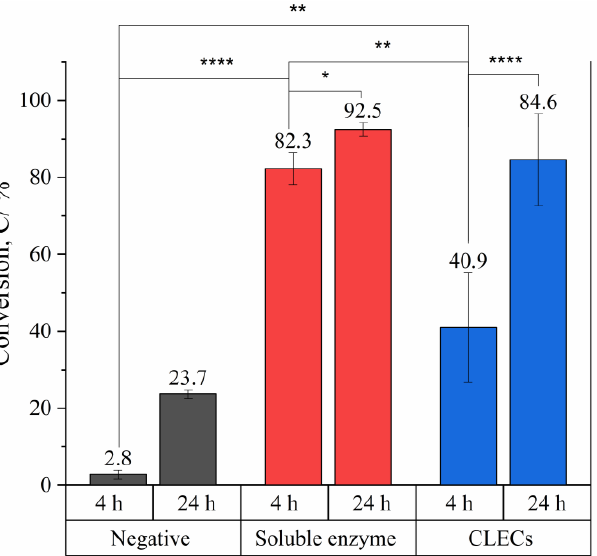
Figure 14. Epoxide ring opening of cyclohexene oxide with azide as a nucleophile after 4 and 24 h. A two-tailed t-test for two random samples was performed with a significance level of p = 0.05. Levels were determined as follows: <0.05 = *, <0.005 = **, <0.0005 = ***, and <0.00005 = ****.